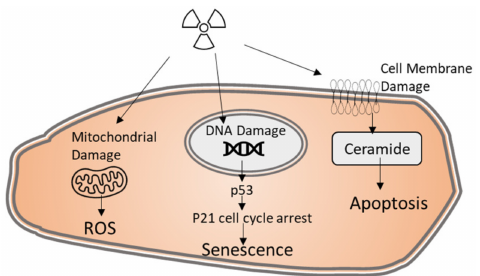
Figure 1. Schematic depiction of the main mechanisms of radiation-induced endothelial cell damage. In endothelial cells, radiation-induced endothelial p53 activation typically promotes p21-mediated cell cycle arrest and the development of a senescent cell phenotype [20]. Although viable, senescent cells are in permanent cell-cycle arrest and can be phenotypi- cally characterized by increased beta-galactosidase activity (SA-B gal) [19]. Several models support radiation-induced senescence downstream of p53 activation in the